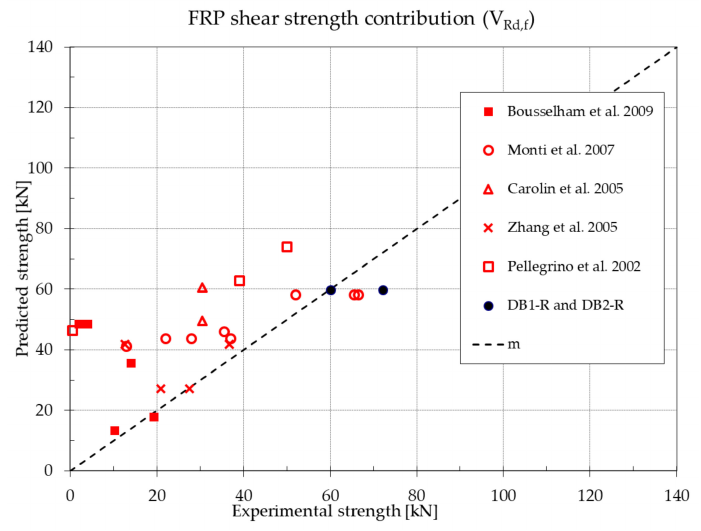
Figure 12. Experimental and predicted values for the CFRP reinforcement contribution to the shear resistance.